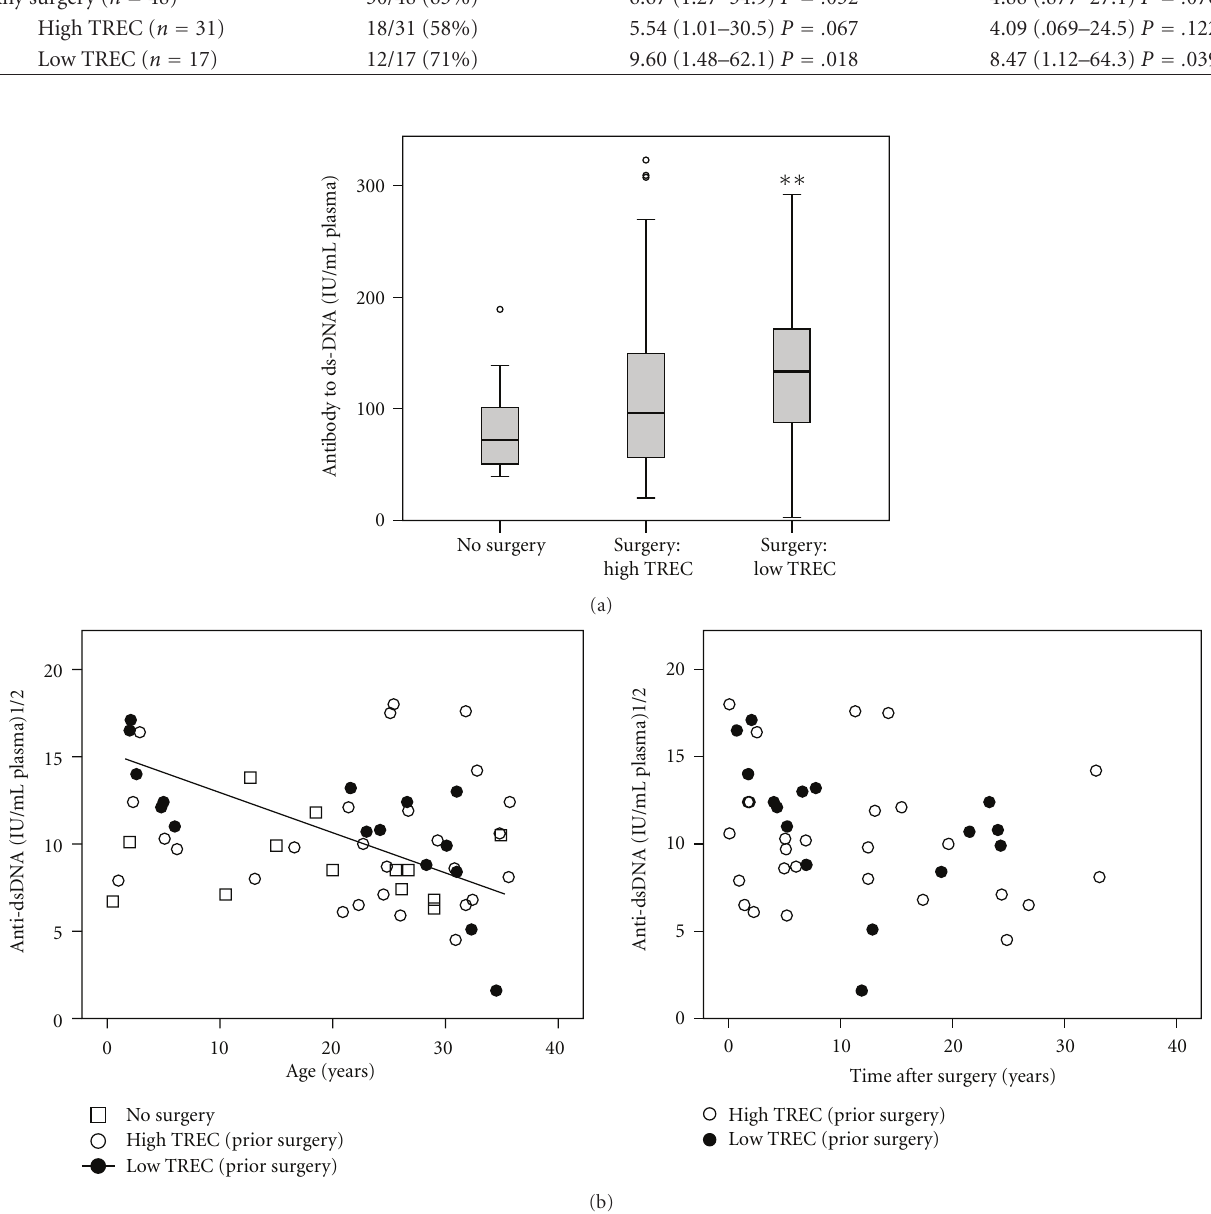
Figure 2: Anti-dsDNA. (a) Anti-dsDNA antibody levels are displayed. Levels were compared between groups using the Wilcoxon rank sum test ( ∗∗ P = . 03 versus No Surgery; 2-tailed asymptotic). (b) Square root transformed anti-dsDNA levels are plotted by age (left panel) and time after last surgery (right panel). Associations were examined using linear regression and the significant trendline for the “low TREC” group is displayed ( P = . 002, adj R 2 = . 477). For the other groups there is no significant association between anti-dsDNA level and age or time since last